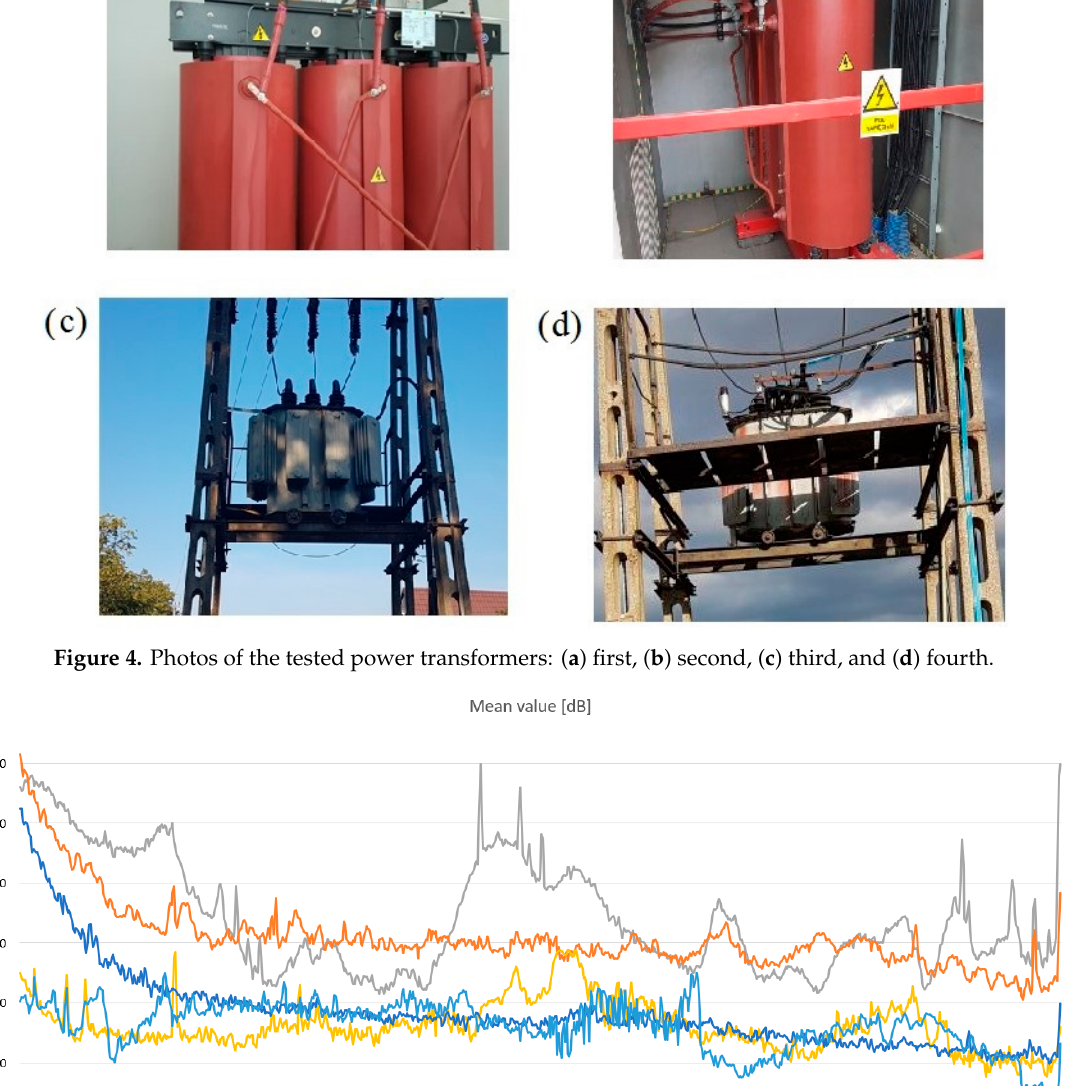
Figure 5. The mean values of transformer noise in the 2–100Hz frequency range.